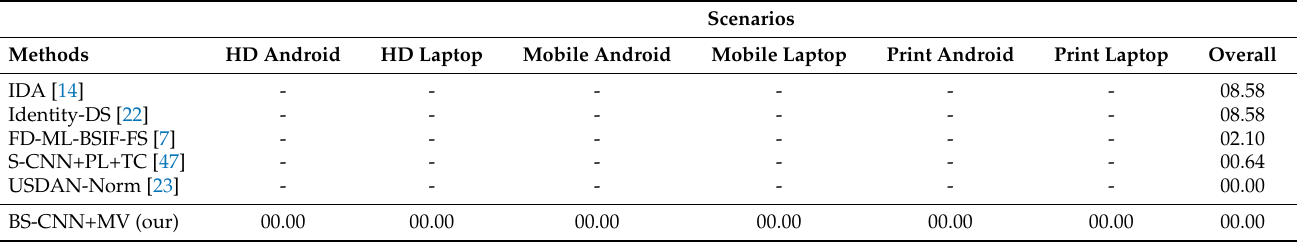
Table 5. Comparison EER (in %) between the proposed approach and the state-of-the-art methods in different scenarios on